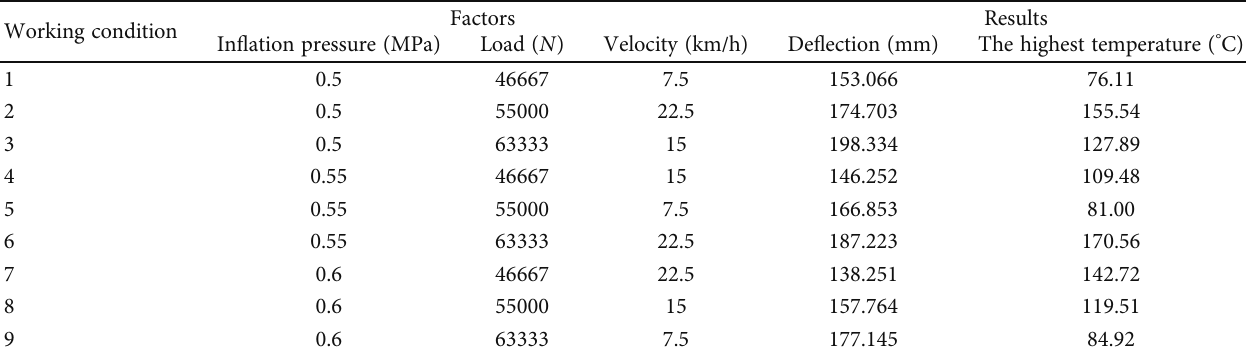
Figure 12: Grounding stress distribution of a 3D tire model under 0.6MPa of in fl ation pressure under loads of (a) 466670 N, (b) 555550N, and (c) 633330 N. Table 8: De fl ection and maximum tire temperature under identical